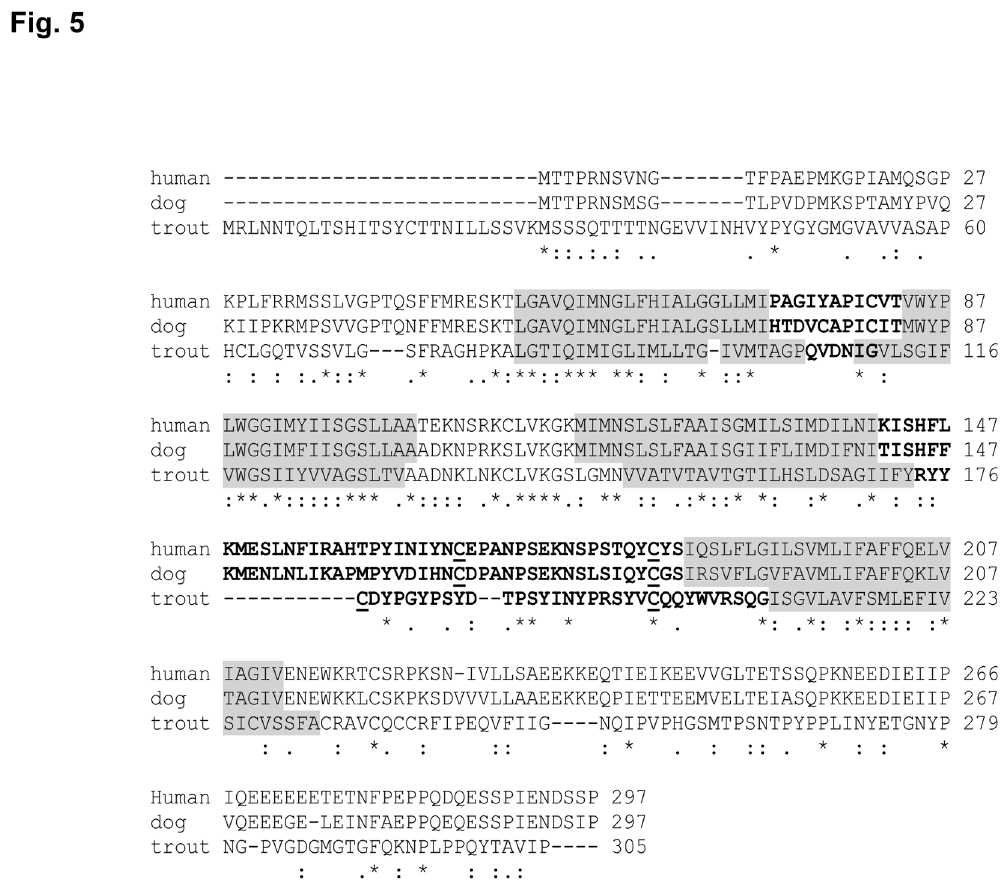
Figure 5. Identification of a rainbow trout MS4A family member. Alignment of predicted rainbow trout MS4A amino acid sequence with CD20 genes in human (NP_690605) or dog (BAE47068.1). Shaded grey residues show predicted transmembrane regions, while bold regions denote predicted extracellular domains. Cystein residues predicted to form a disulphide bond in the second extracellular loop are underlined. Identical residues from the aligned sequences are indicated by “*” below the alignment. Similar residues are marked by “.” or “ : ” below the